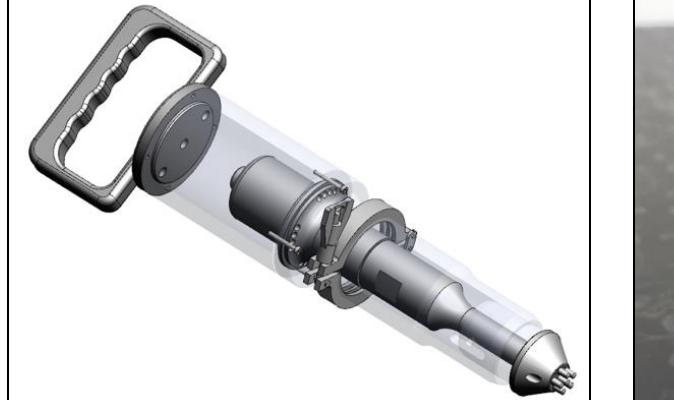
Figure 2. Ultrasonic peening device. ( a ) Diagram of an ultrasonic peening device; ( b ) Photograph of a three-tip ultrasonic peening device.